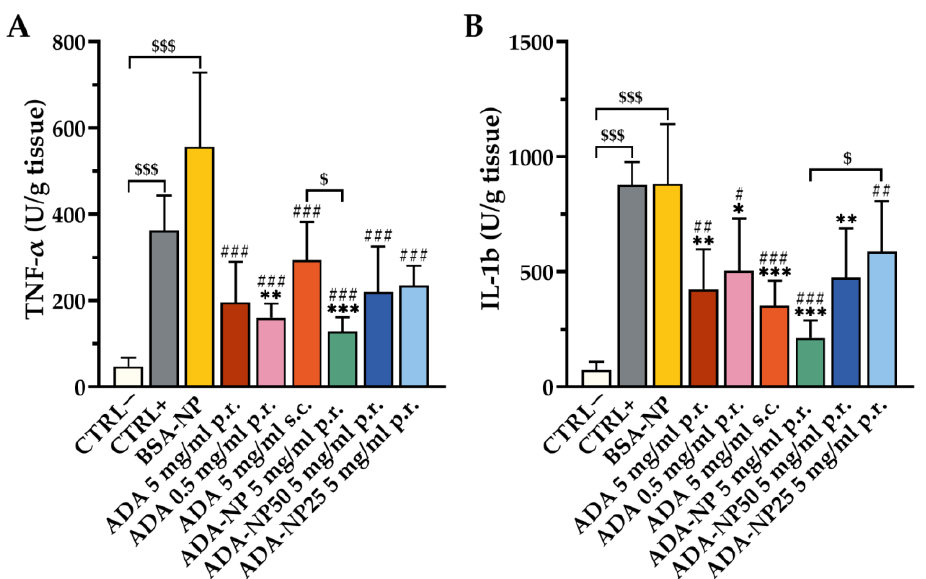
Figure 9. Anti-inflammatory effect of adalimumab (ADA) treatment on cytokine levels. Intestinal concentrations of ( A ) tumor necrosis factor α (TNF- α ) and ( B ) interleukin-1b (IL-1b) in colon tissue of colitis mice. Colitis was induced by rectal administration of TNBS (90 mg/kg body weight), and the mice were treated for 3 consecutive days. Cytokines were measured in colon tissue using ELISA. Data are shown as mean ± SD ( n = 6). Statistical significance was assessed by one-way ANOVA followed by Tukey’s multiple comparisons test (* p < 0.05, ** p < 0.01, *** p < 0.001 vs. CTRL+; # p < 0.05, ## p < 0.01, ### p < 0.001 vs. BSA-NP; $ p < 0.05, $$$ p < 0.001). ADA-NP, ADA conjugated